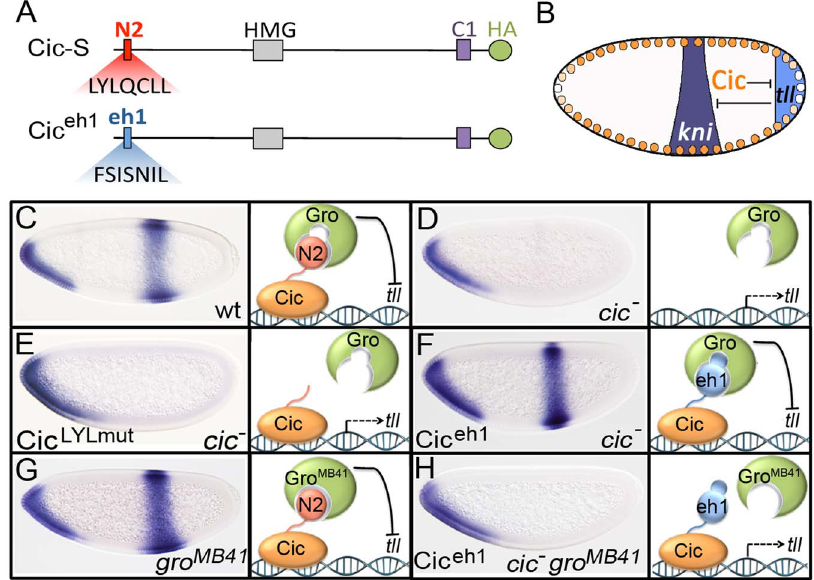
Fig. 5. The N2 motif of Cic recruits Gro to the terminal patterning system. (A) Diagram of Cic and Cic eh1 proteins; Cic eh1 carries the eh1 motif from Drosophila Engrailed instead of N2 and is tagged with an HA epitope at the C-terminus. (B) Schematic representation of cross-repressive interactions between Cic, tll and kni in the early blastoderm. (C-H) mRNA expression patterns of kni in wild-type (C), cic (D, E, F), gro MB41 (G) and cic gro MB41 (H) mutant backgrounds expressing the Cic LYLmut (E) and Cic eh1 (F, H) products. A model diagram depicting the interactions of N2 and eh1 motifs with Gro proteins and the resulting repressor activities is shown next to each embryo; for simplicity, the interaction between N2 and Gro is modeled as being direct (see Discussion). The cic maternal mutant genotypes are cic 1 for panels D, F and H, and cic 1 /cic Q474X for panel E.